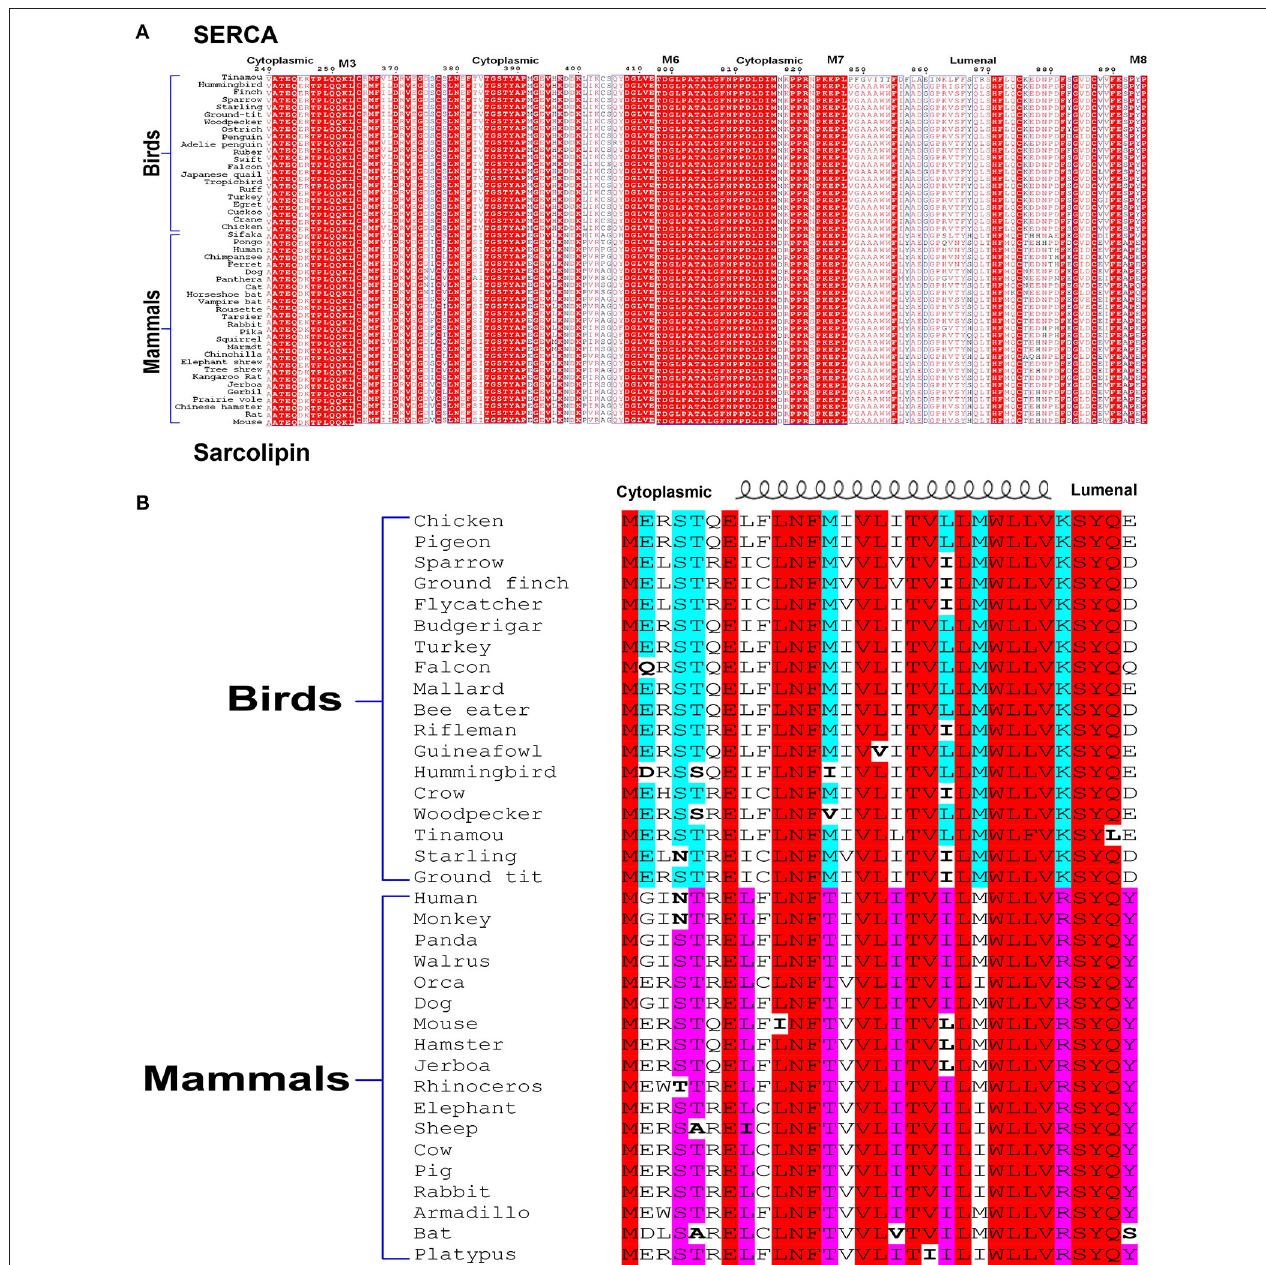
FIGURE 1 | Alignment of SERCA (A) and SLN (B) sequences. Comparison of SERCA sequences from various species of birds and mammals shows that the cytosolic residues that may potentially interact with SLN do not have strict conservation. SLN sequences also show divergence more on the N-terminal cytosolic and C-terminal luminal side. Like other transmembrane proteins, transmembrane residues of both the proteins are more strictly conserved. Therefore, avian SLN may be better suited to uncouple avian